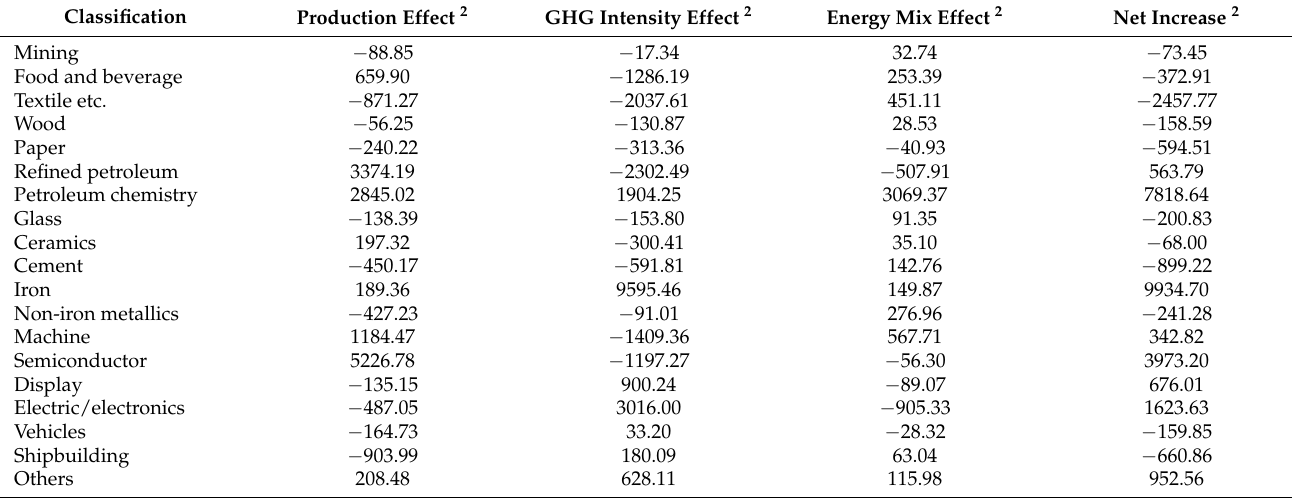
Table 3. Decomposition results of LMDI 1